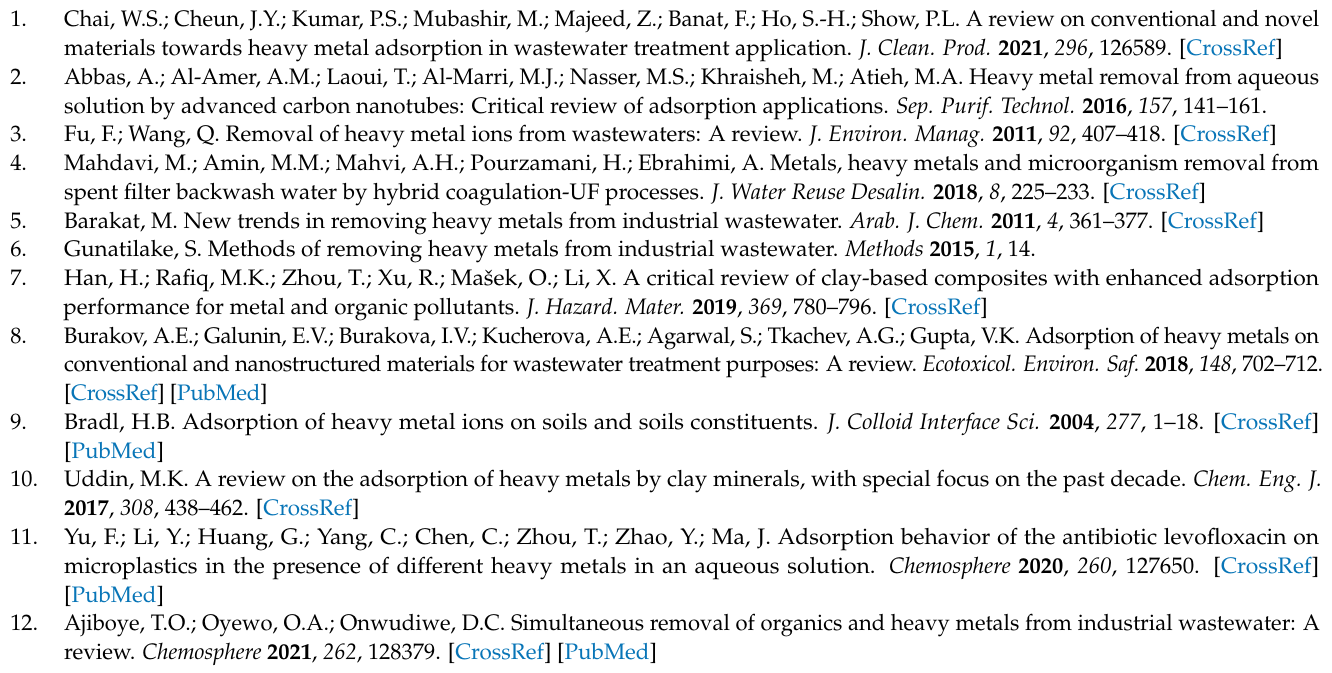
Figure S2: SEM image of the polyaniline, Figure S3: The comparison- of adsorption capacities of WPT, PANI and PANI@WTP for Cu(II) and phenol removal. (concentration; 100 mg/L, adsorbent